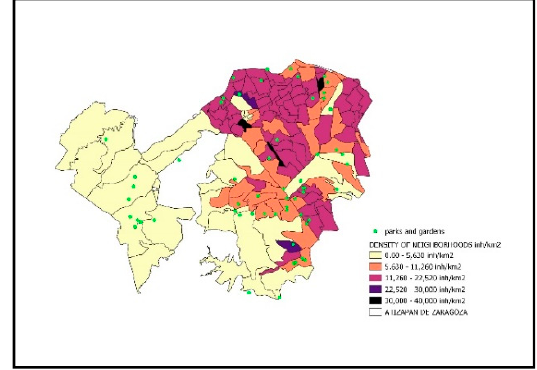
Figure 6. Urban density and public parks. (this figure is by authors, with data from Municiaplity of Atizapan and Conapo 2015 [44]). Table 4. Quantitative distribution of the marginalization in zones (elaborated by the authors with data from Conapo, 2015 [44]).